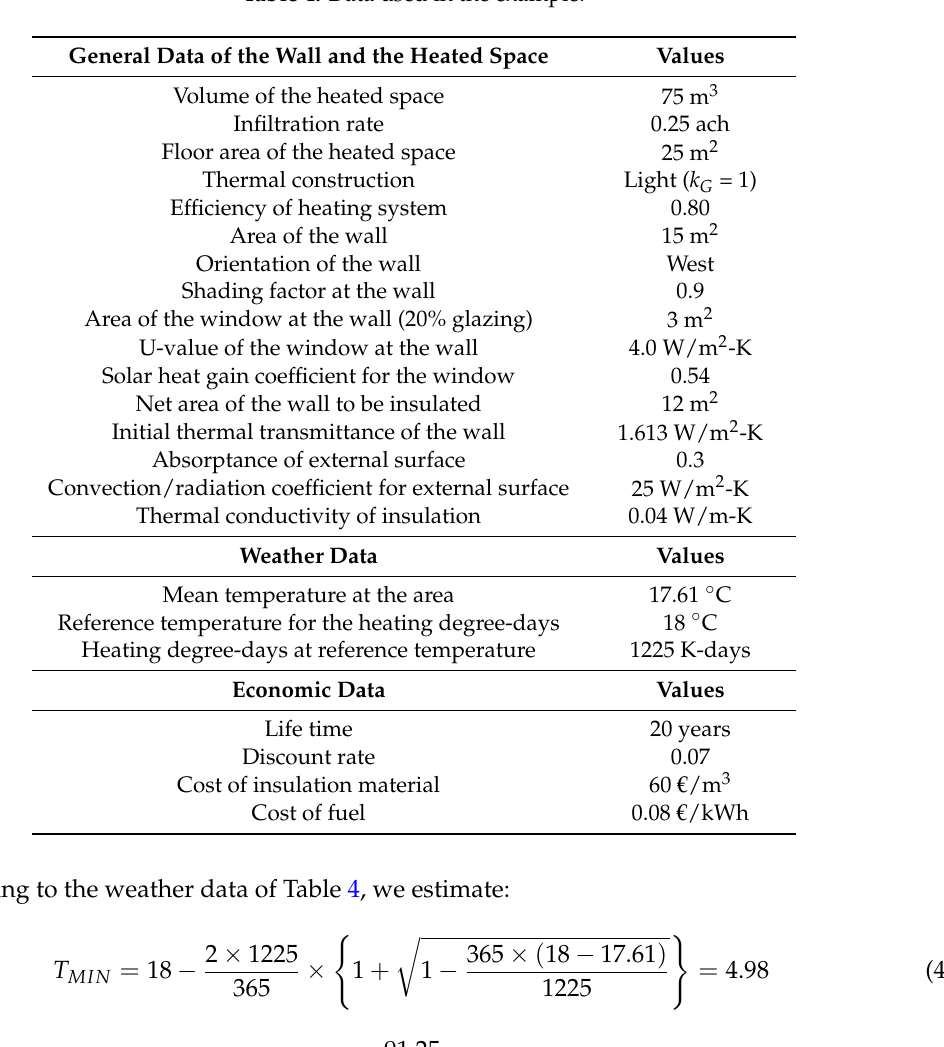
Table 4. Data used in the example.